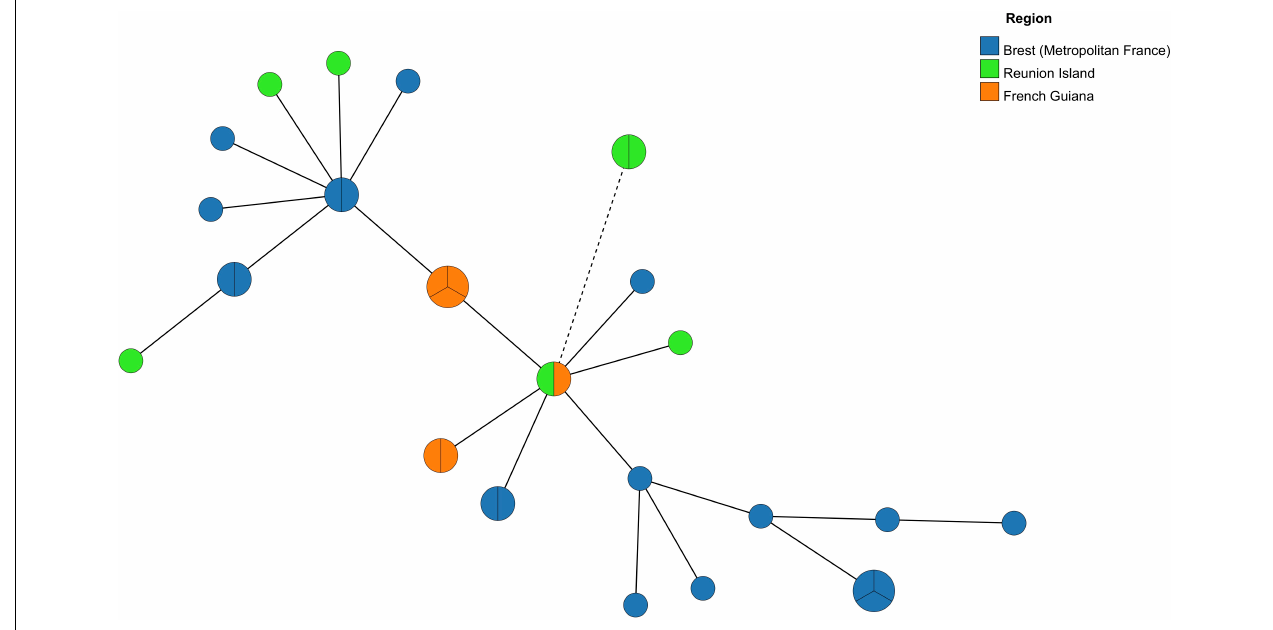
FIGURE 3 | Minimum Spanning Tree analysis of Pneumocystis isolates from six Reunionese patients, five Guianese patients and 15 Brest (Metropolitan France) patients harboring one multilocus genotype (MLG) (one allele per locus) or two MLGs (two alleles for one locus). Each circle corresponds to one MLG. The size of the circles is correlated with the number of isolates possessing the corresponding MLG. The color of the circles indicates the origin region of the Pneumocystis isolates. A continuous connecting line corresponds to one different allele separating two MLGs. A dashed connecting line corresponds to two different alleles separating two